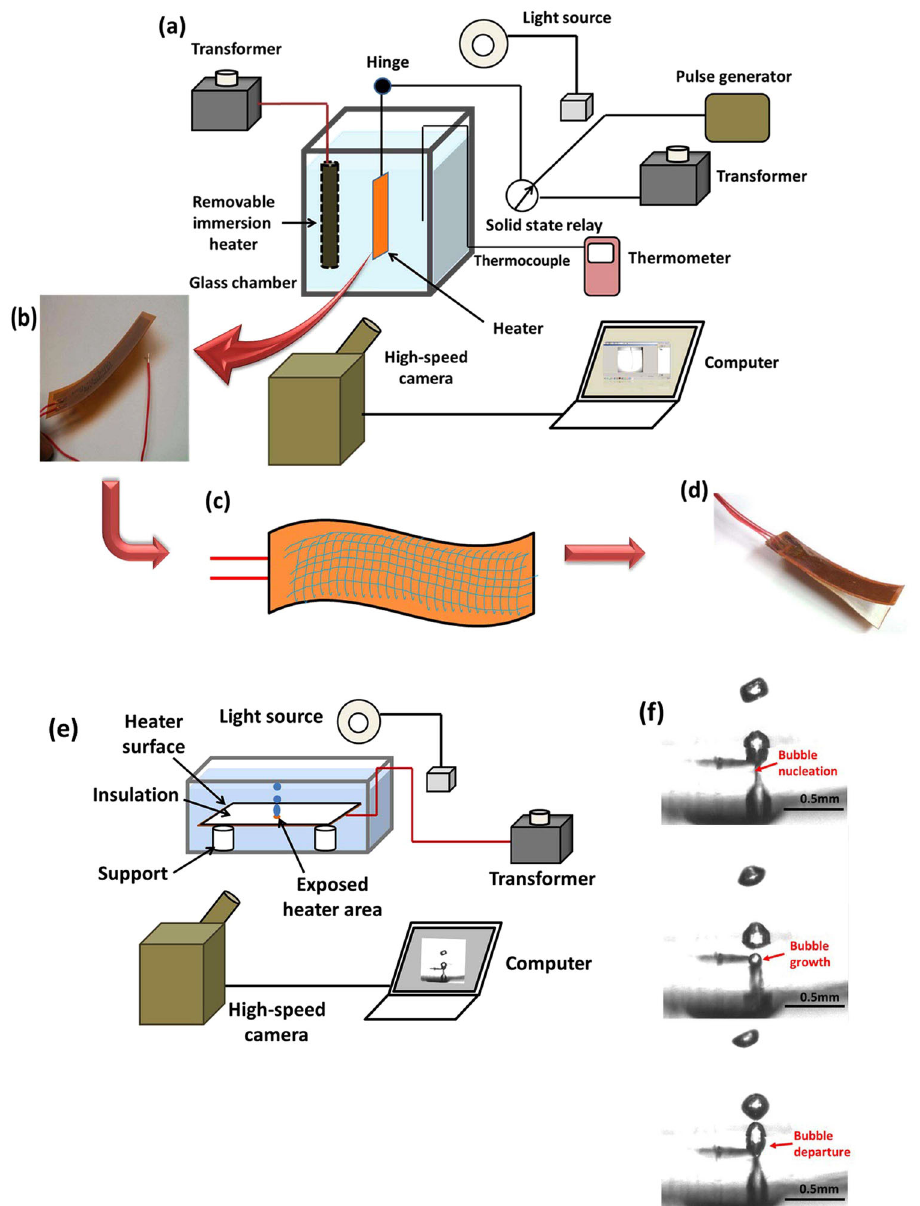
Fig. 6 Experimental set-up and the fl exible heater surface. a Pool boiling cell b Photograph of the heater. c Sketch of a heater with deposited nano fi ber mat. d Photograph of the heater assembly with two convex sides being attached after a proper insulation, and boiling occurring only on the outside concave sides. e Single bubble nucleation cell. f Three snapshots elucidating a single bubble nucleation, growth, and detachment from a single nucleation site. The total time span is 9.3